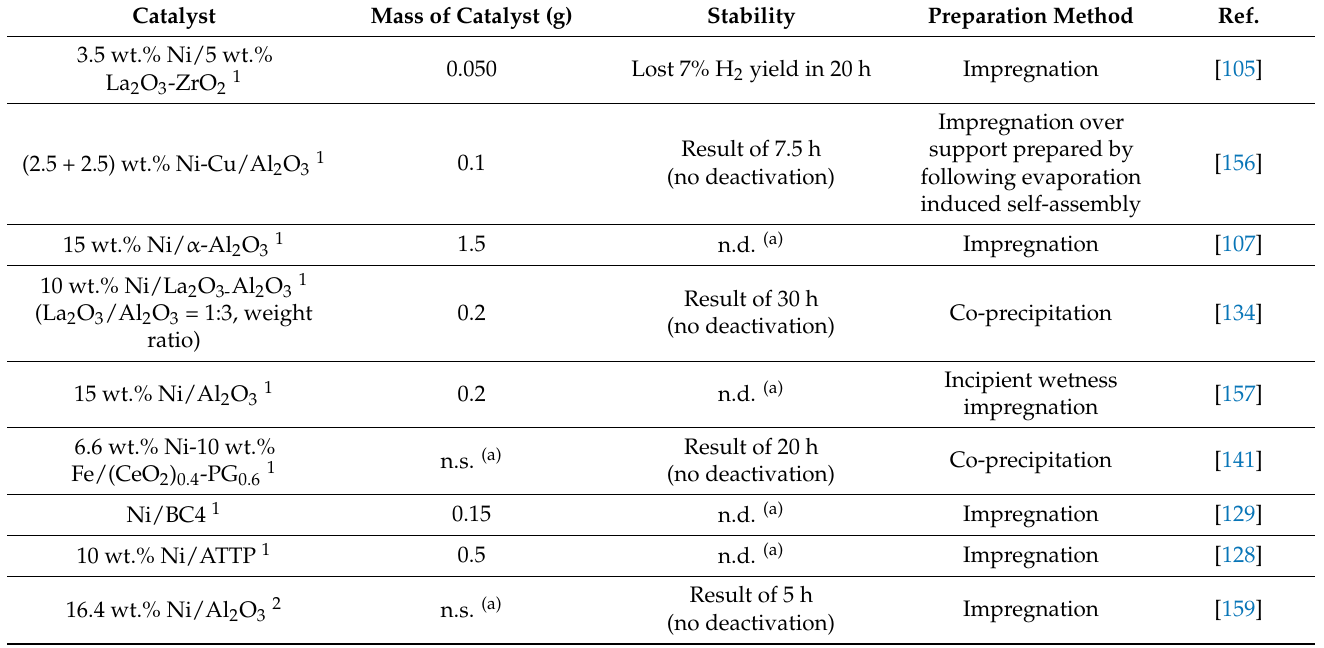
Table 5. Stability and preparation methods for Ni-based catalysts used on steam reforming reactions of oxygenated